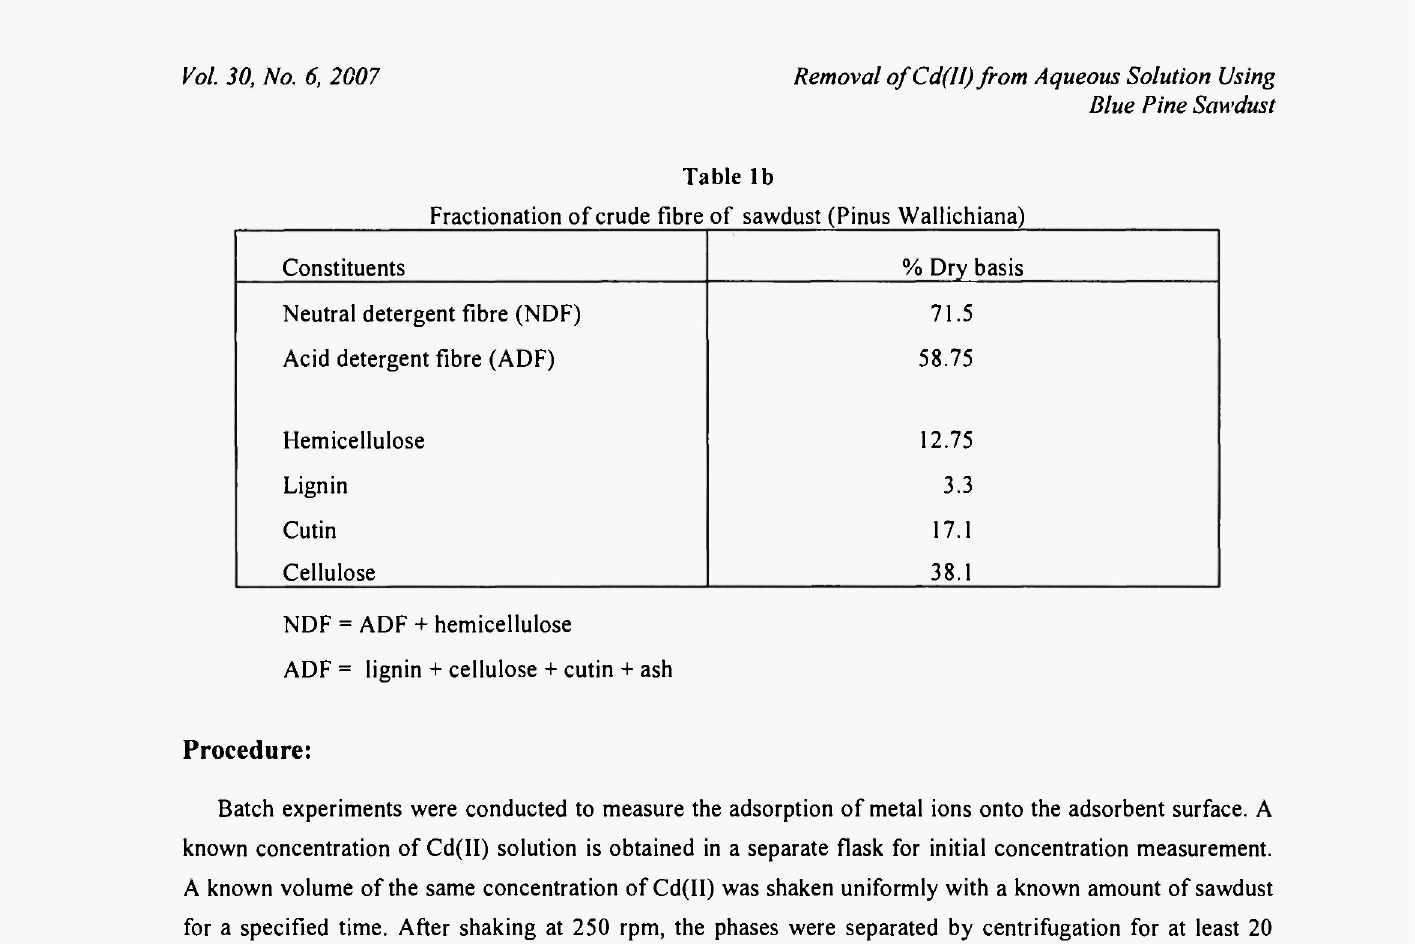
Fractionation of crude fibre of sawdust (Pinus